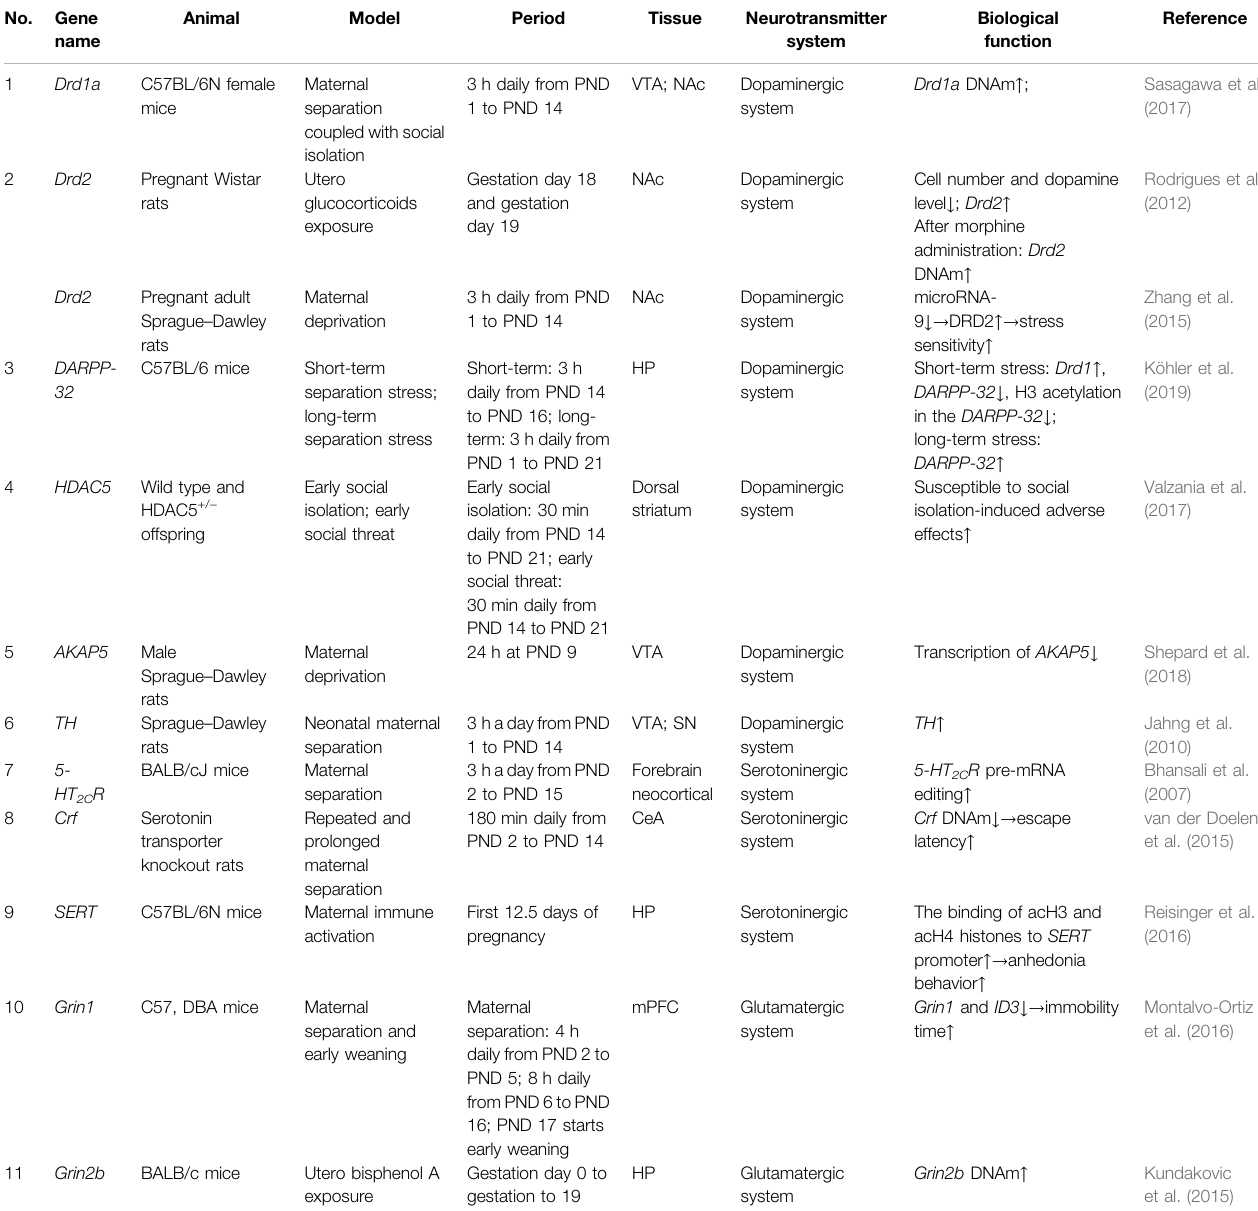
TABLE 1 | Summary of different types of ELS-induced epigenetic changes in neurotransmitter system-related genes in animal models mentioned in this